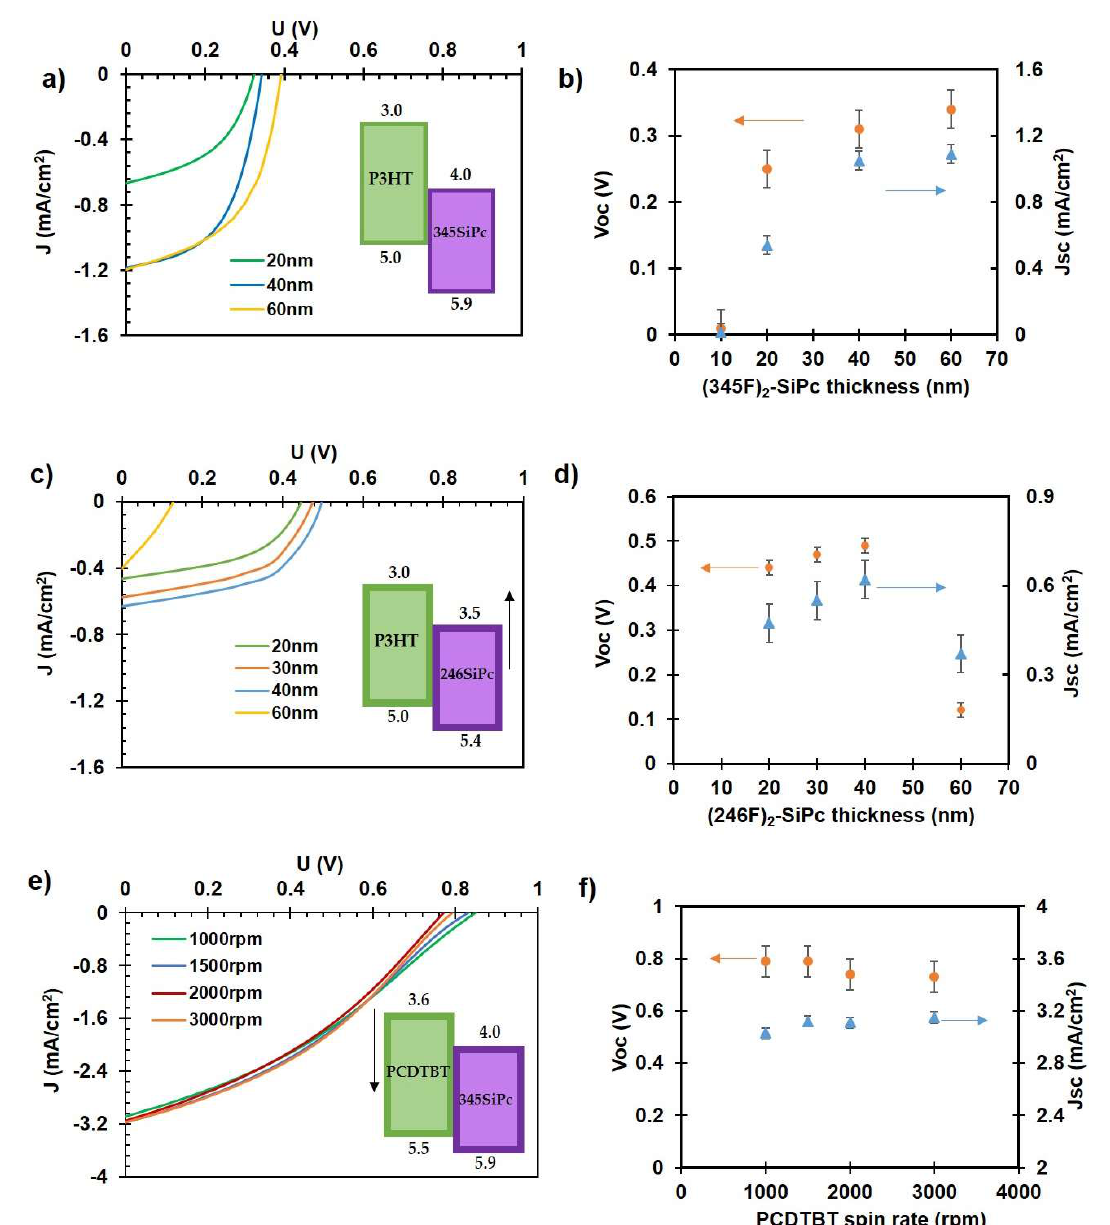
Figure 2. Characteristic ( a,c,e ) current vs. voltage and averaged open-circuit voltage ( V oc), and short circuit current ( J sc) as a function of ( b,d ) acceptor thickness or ( f ) spin speed of PCDTBT layer. ( a,b ) (345F) 2 -SiPc on P3HT; ( c,d ) (246F) 2 -SiPc on P3HT; ( e,f ) 60 nm (345F) 2 -SiPc on different films of PCDTBT. Values for the figure inset band diagrams were taken from the literature [18,48,53].